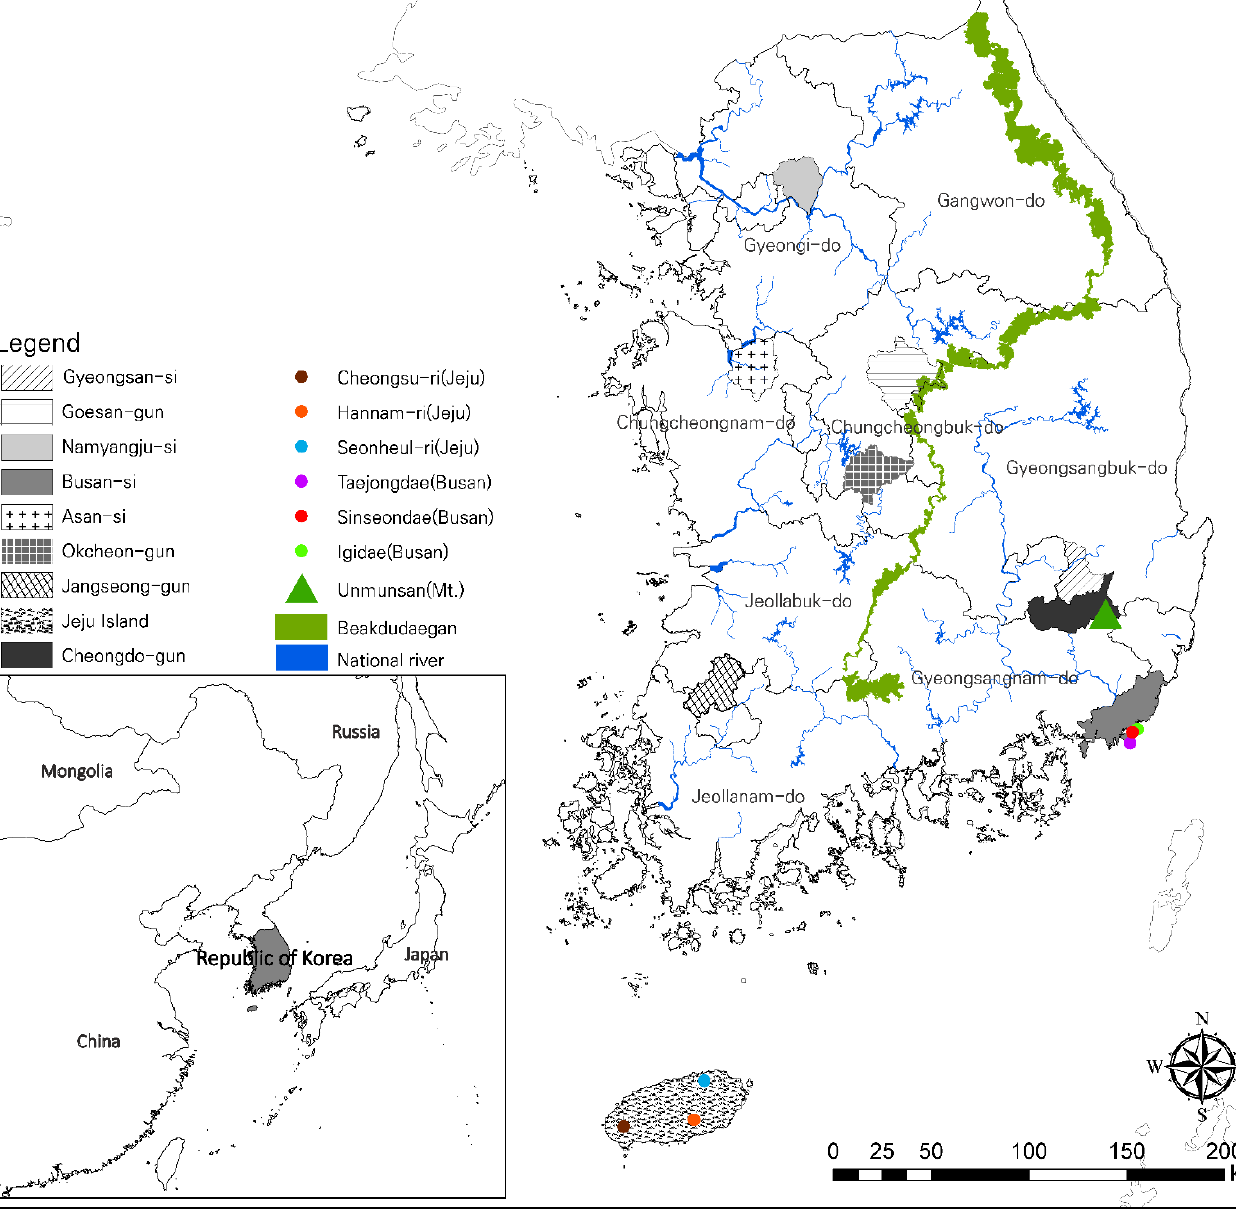
Figure 1. Study sites for L. unmunsana.